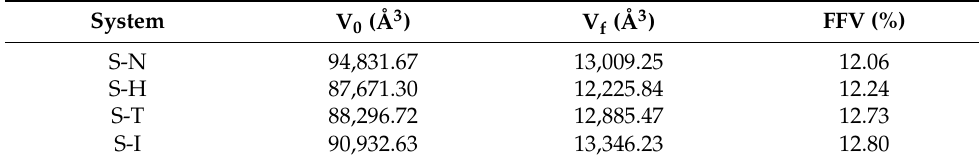
Figure 9. The free volumes of four crosslinking IPN binder models. ( a ) S-N, ( b ) S-H, ( c ) S-T and ( d ) S-I. Table 1. The results of V 0 , V f and FFV in HTPE/PEG interpenetrating polymer structure models.